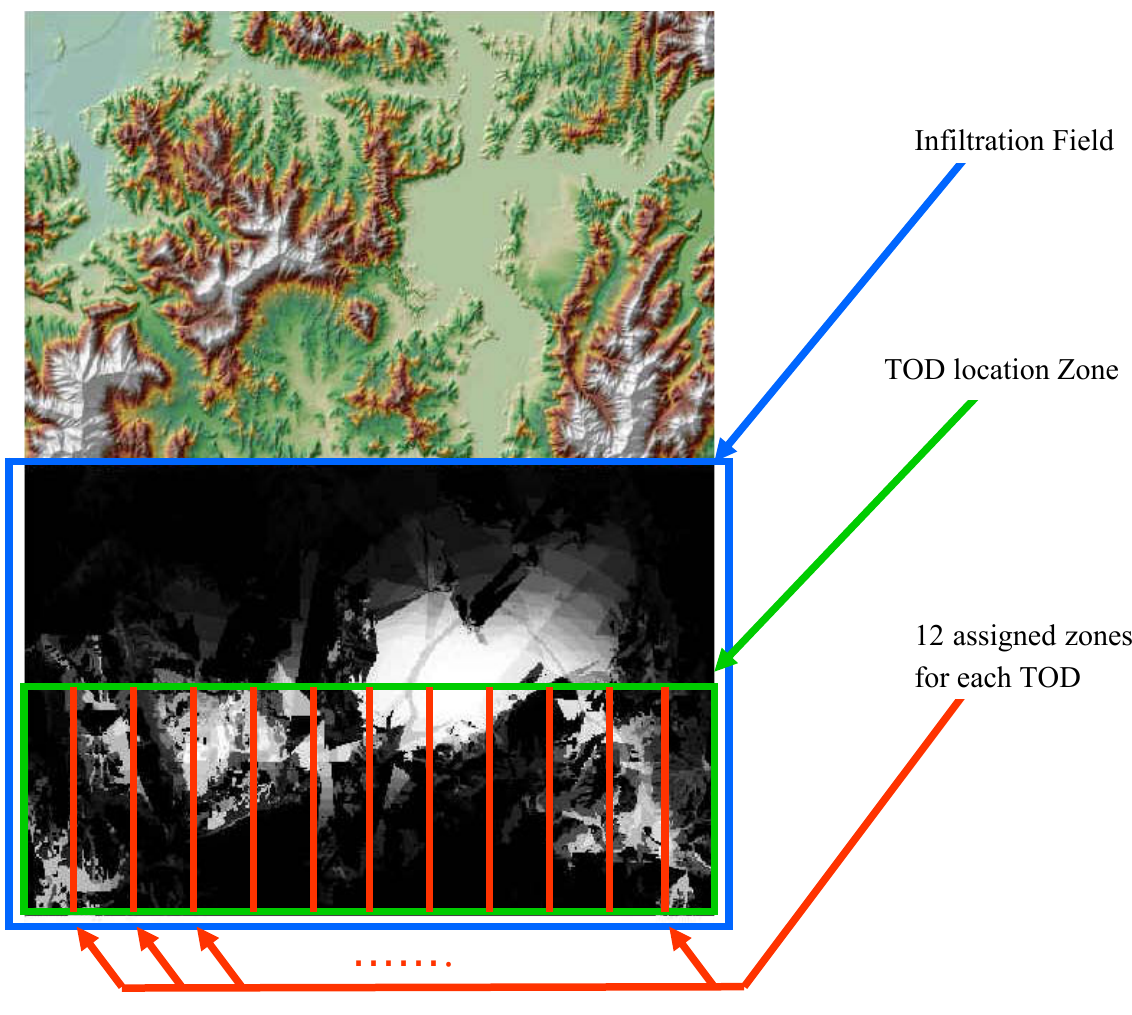
Figure 10. Setup for dynamic